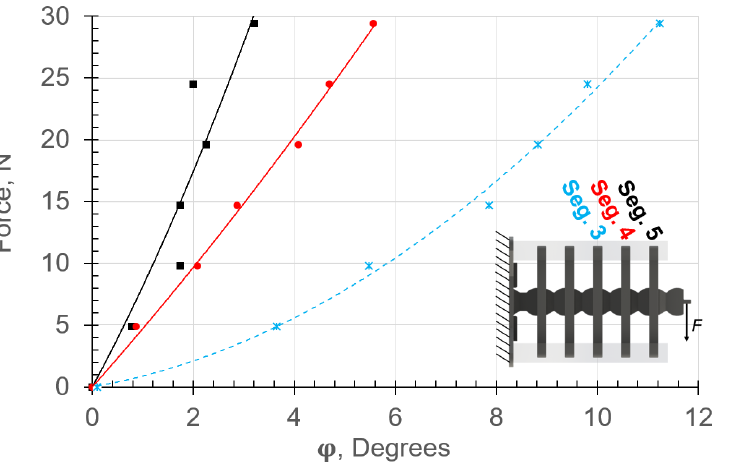
Figure 15. Force–response curves for horizontal loading obtained by applying force at the end of the top rigid segment. Experimental and analytical (from (9)) results are shown in markers and lines, respectively. Note the nonlinear bending behavior due to contraction of the soft material on one side and stretch on the